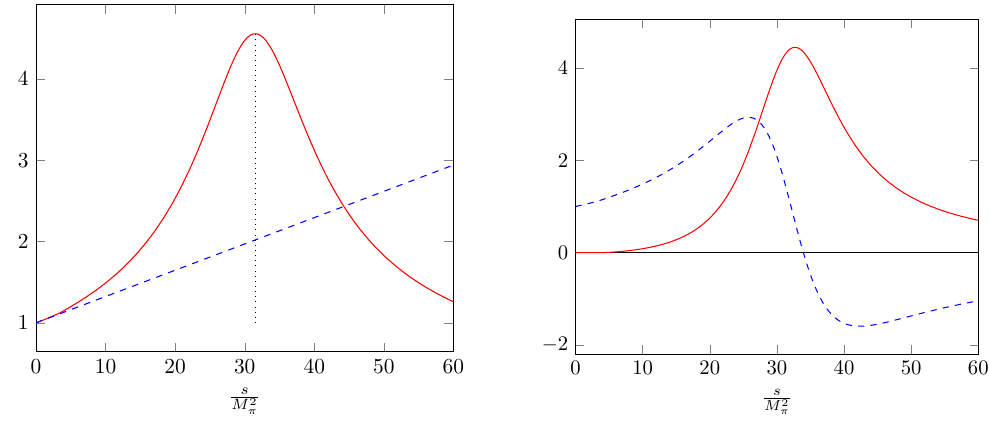
F (cid:25) ( s ) at one loop (dashed line) and its IAM V j j , for s 4 M 2 and for M V = M (cid:26) = 775 MeV (cid:25) (cid:25) (cid:21)